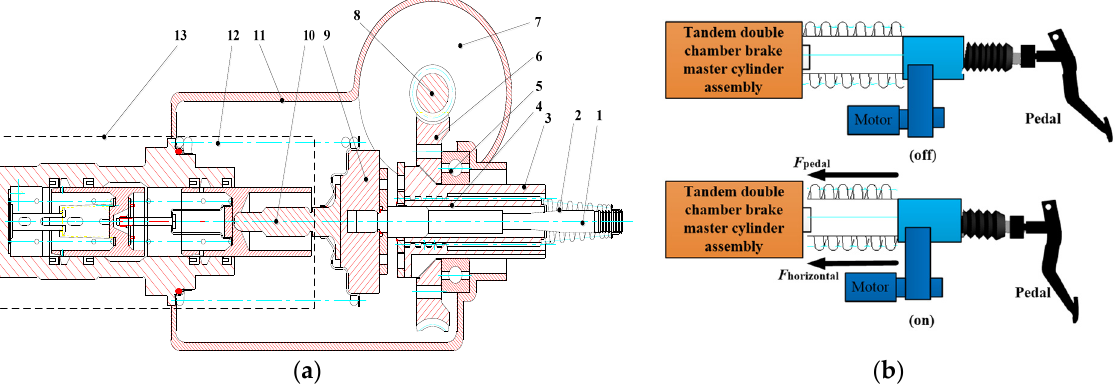
Figure 2. The electric servo booster structure. ( a ) Mechanical structure of electric servo booster. ( b ) The working states.1—input push rod; 2—cone spring; 3—nut; 4—lead rod; 5—deep groove ball bearing; 6—turbowheel; 7—power motor mounting hole; 8—worm; 9—feedback disk; 10—master cylinder push rod; 11—housing assembly; 12—return spring; 13—tandem double chamber brake master cylinder assembly.